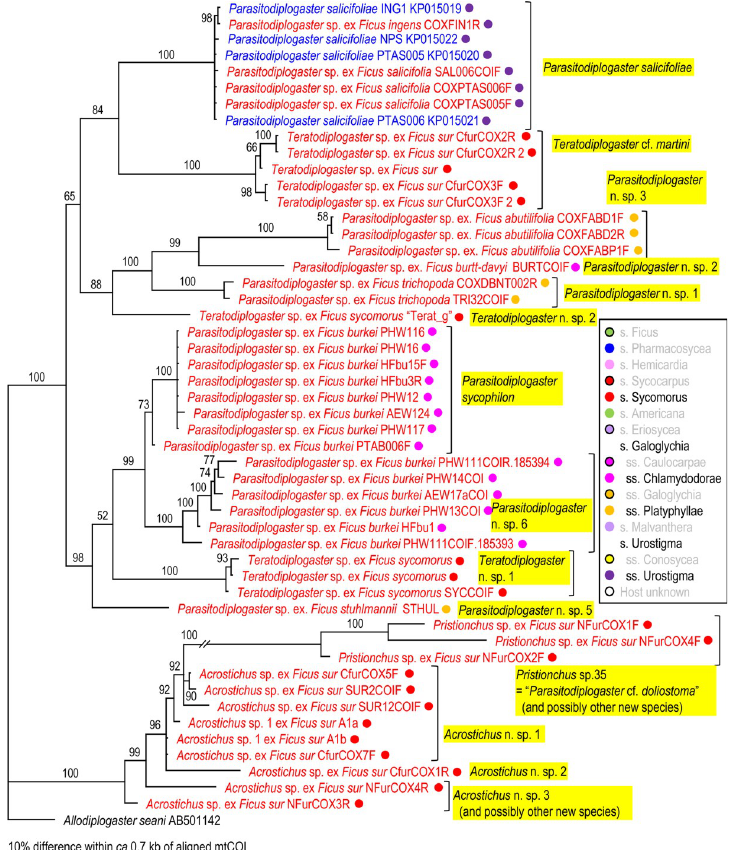
Fig 7. Phylogenetic relationship of fig-associated Diplogastridae species inferred from mtCOI under GTR + G model. The parameters are: AIC = 9938.549, lnL = -4858.882, freqA = 0.26, freqC = 0.12, freqG = 0.19, freqT = 0.43, R (a) = 0.44, R(b) = 3.03, R(c) = 1.72, R(d) = 0.68, R(e) = 3.24, R(f) = 1.00, Pinva = n/a, Shape = 0.32. Posterior probability values exceeding 50% are given on appropriate clades. Fig-associated nematode species obtained in the present study and previous studies are written in red and blue, respectively. Section or subsection of host fig species are coded with color dots.